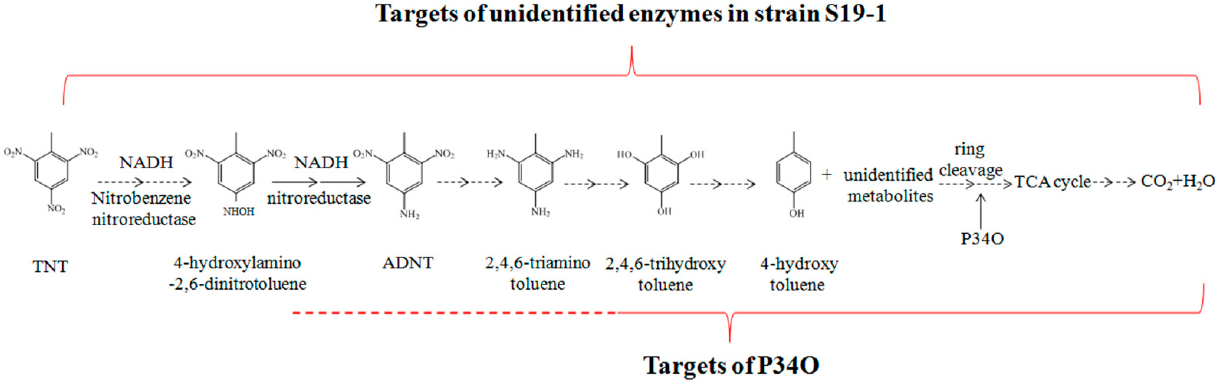
Figure 8. Proposed degradation pathway for TNT and ADNT in wild-type Buttiauxella sp. S19-1. TNT is sequentially reduced at its nitro moieties by nitroreductase via ADNT to 2,4,6-aminotoluene. Further de-amination leads to hydroxytoluenes and other unidentified metabolites that are the ring cleavage substrate(s) for P34O to yield TCA cycle metabolites and finally resulting in complete mineralization, adapted from [15], 2018, Elsevier.